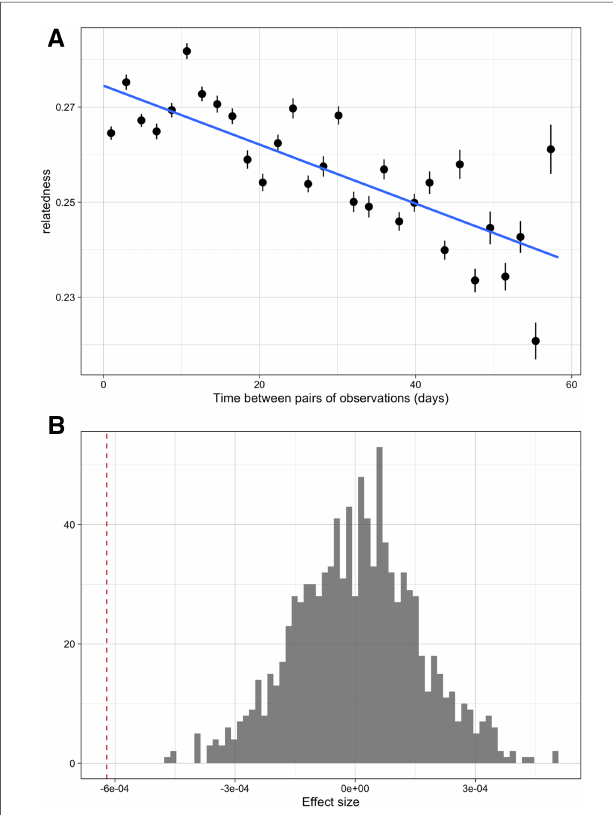
FIGURE 1 The overall patterns of relatedness across time amongst samples from the cohort data. ( A ) Relationship between pairwise relatedness and time between samples. Points represent averages of pairs of observations similar numbers of days apart. ( B ) The effect of time between infections in weeks on relatedness (red dashed line) compared to a null distribution where there is no temporal structure to relatedness (grey histogram).